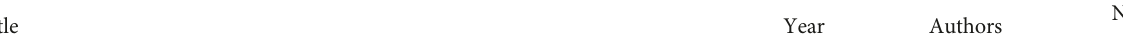
“ Vonoprazan, A Novel Potassium-Competitive Acid Blocker, as a Component of First-Line and Second-Line Triple Therapy for Helicobacter pylori Eradication: A Phase III, Randomised, Double-Blind Study ” “ Randomised Clinical Trial: Safety, Tolerability, Pharmacokinetics and Pharmacodynamics of Repeated Doses of TAK-438 (Vonoprazan), a Novel Potassium-Competitive Acid Blocker, in Healthy Male Subjects ” “ Safety, Tolerability, Pharmacokinetics, and Pharmacodynamics of Single Rising “ Vonoprazan versus Conventional Proton Pump Inhibitor-Based Triple Therapy as First-Line Treatment against Helicobacter pylori : A Multicenter Retrospective Study in Infection: A Single-Center Experience with 1118 Patients